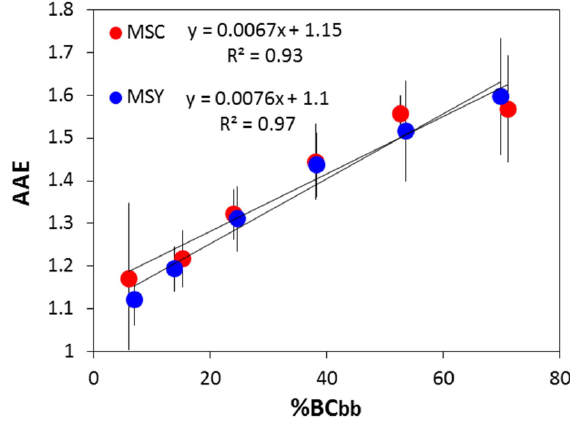
Figure 7. Scatter plot by bins between AAE and %BC bb at MSY and MSA. Error bars are one standard deviation of the averages calculated from daily